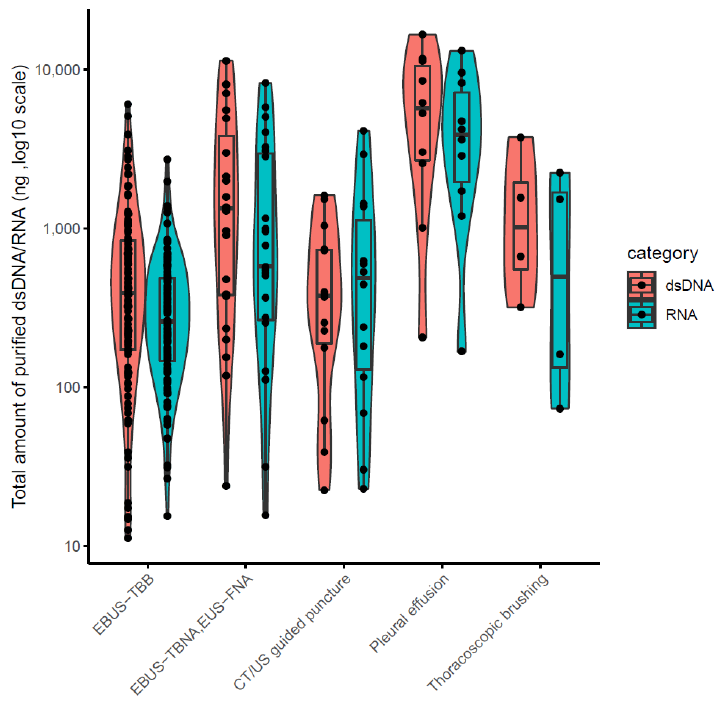
Figure 3. DNR/RNA yield from 163 cytology samples.